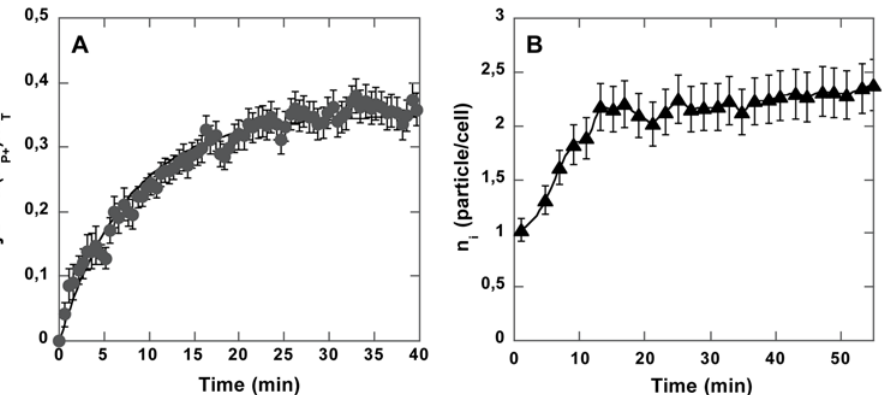
Figure 2. Cell-anti-CD3 particle binding kinetics. e c , the ratio of the number of particle-bearing cells (number events in R p + ) to the total number of cells N T is shown as a function of time (A). 2 6 10 6 /ml T cells were brought into contact with 2 6 10 7 /ml anti-CD3 grafted particles under mild stirring. Experimental points ( m ) were adjusted according to e c (t)=N max /N T (1 2 exp(kt)) (solid line). Time dependence of the mean number of particles bound per cell (n i ) is given in B.